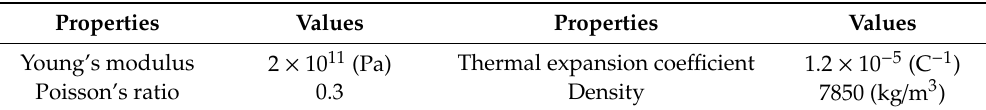
Table 8. Main performance